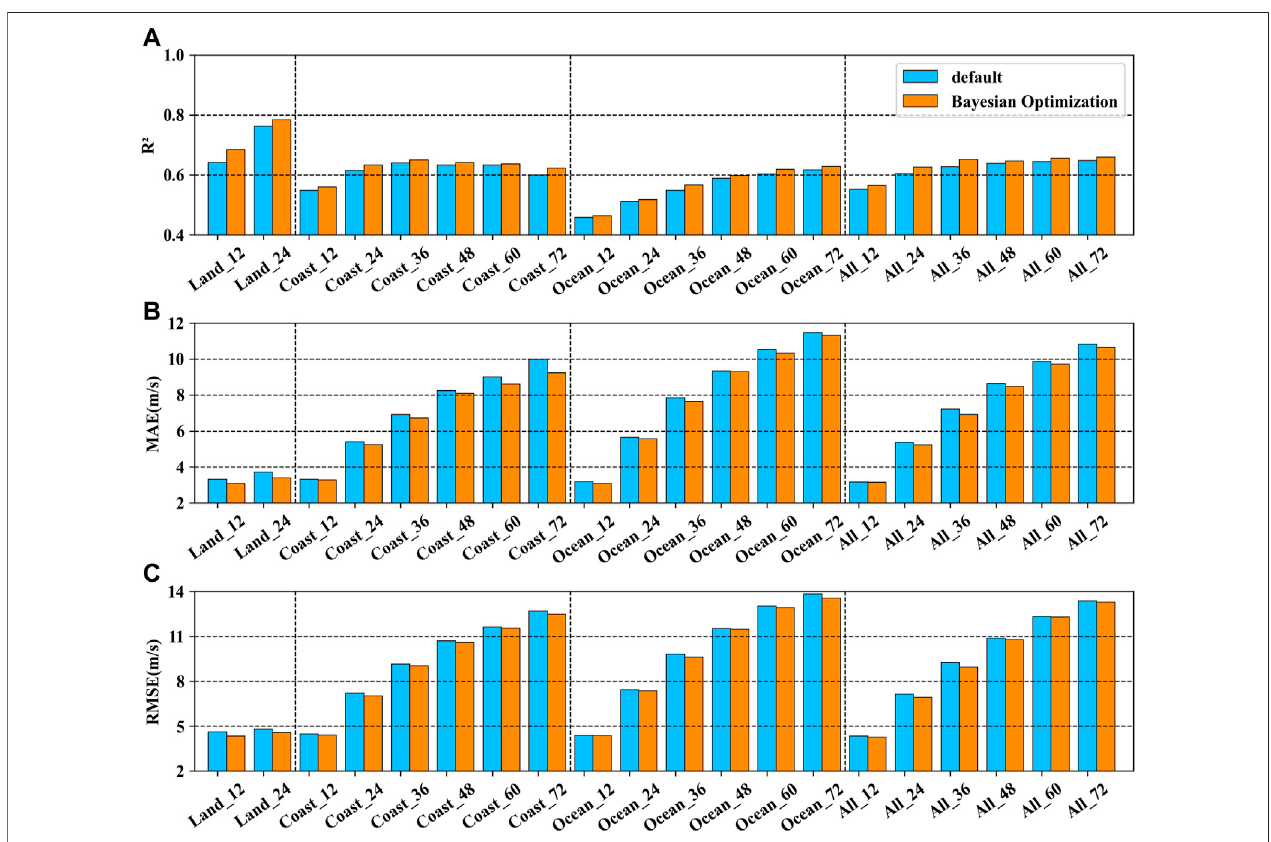
FIGURE 7 | Performance comparison between the GBRT model with the default hyperparameters and Bayesian optimized GBRT model in terms of (A) R 2 , (B) MAE,and (C) RMSEforTCsintensitychangeprediction basedontheJTWCdata.ThelabelsofLand,Coast,Ocean,and Allinthe fi gures refertoTCsamplesoverland, near the coast, over the open ocean, and all TC samples,